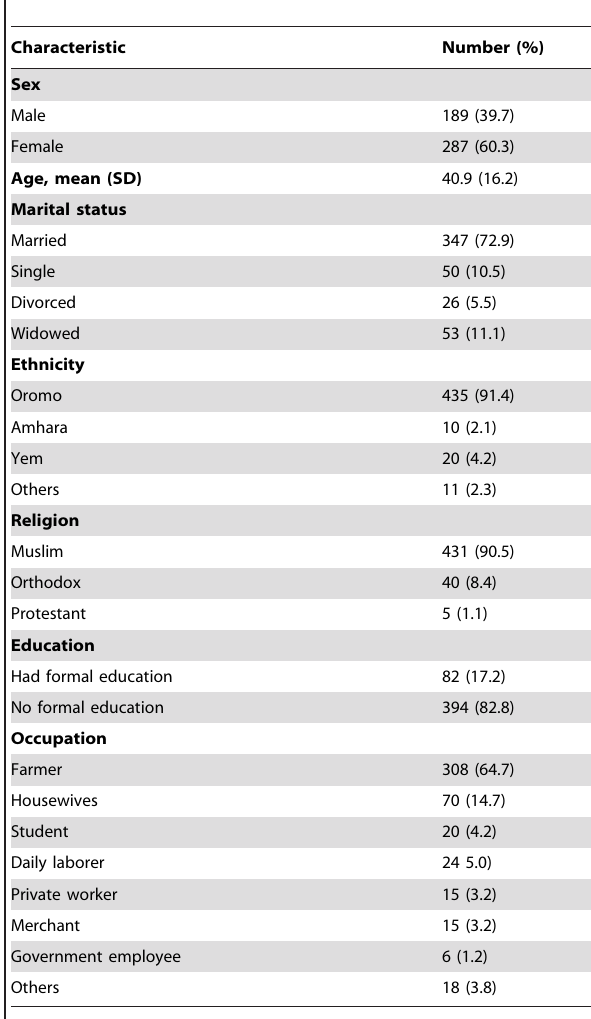
Table 1. Socio-demographic characteristics of the TB suspects (n=476) in the Gilgel Gibe field research area, south west Ethiopia, March